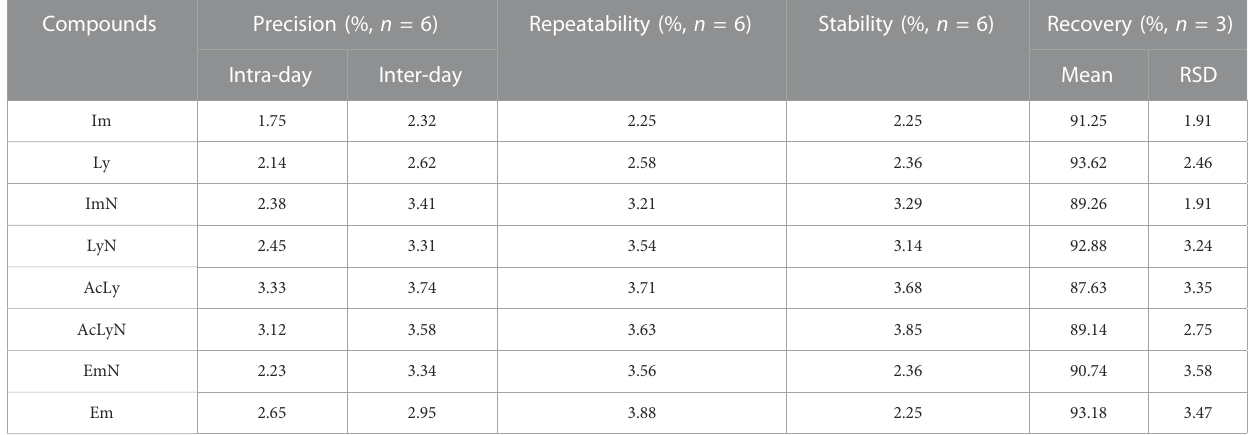
TABLE 4 Precision, repeatability, stability and recovery results of the 8 PAs. Compounds